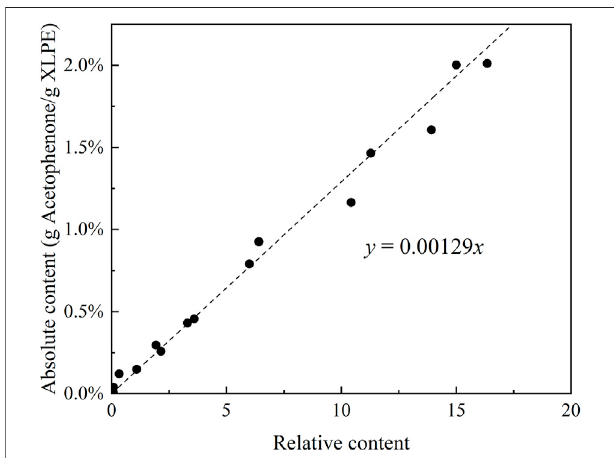
FIGURE 3 | Relative content and absolute content of acetophenone in immersed XLPE samples.